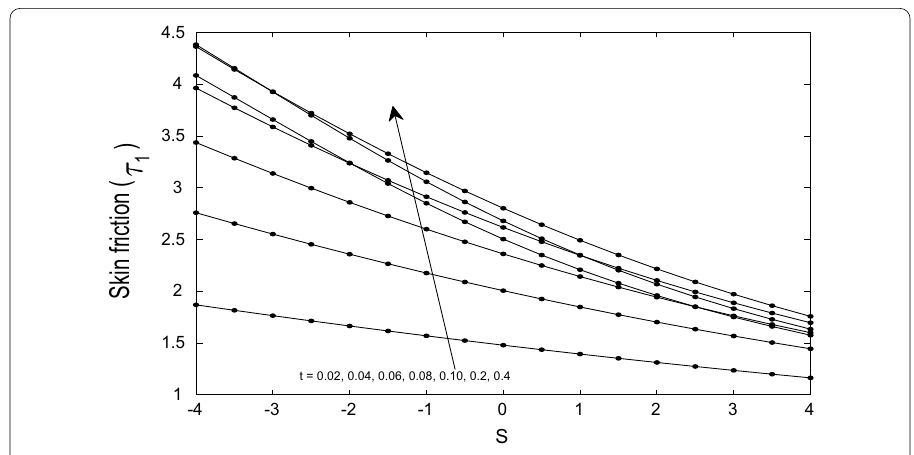
0.2, P 10,Da 0.2, d 1.5, A ∗ 1, w 0.8 ) = − = = = = =